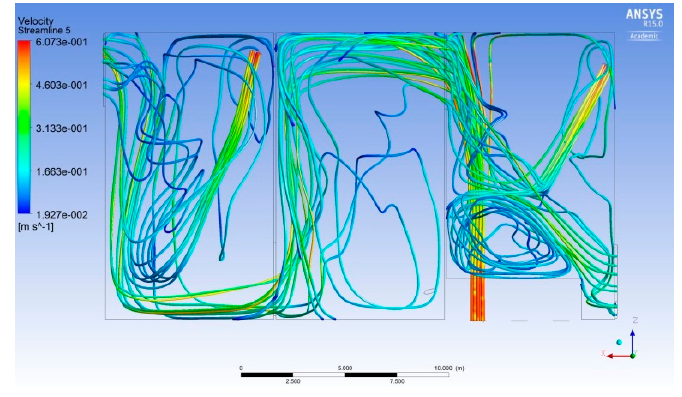
Figure 13. Streamline path plot of reduced mixer duration (2.5 min).